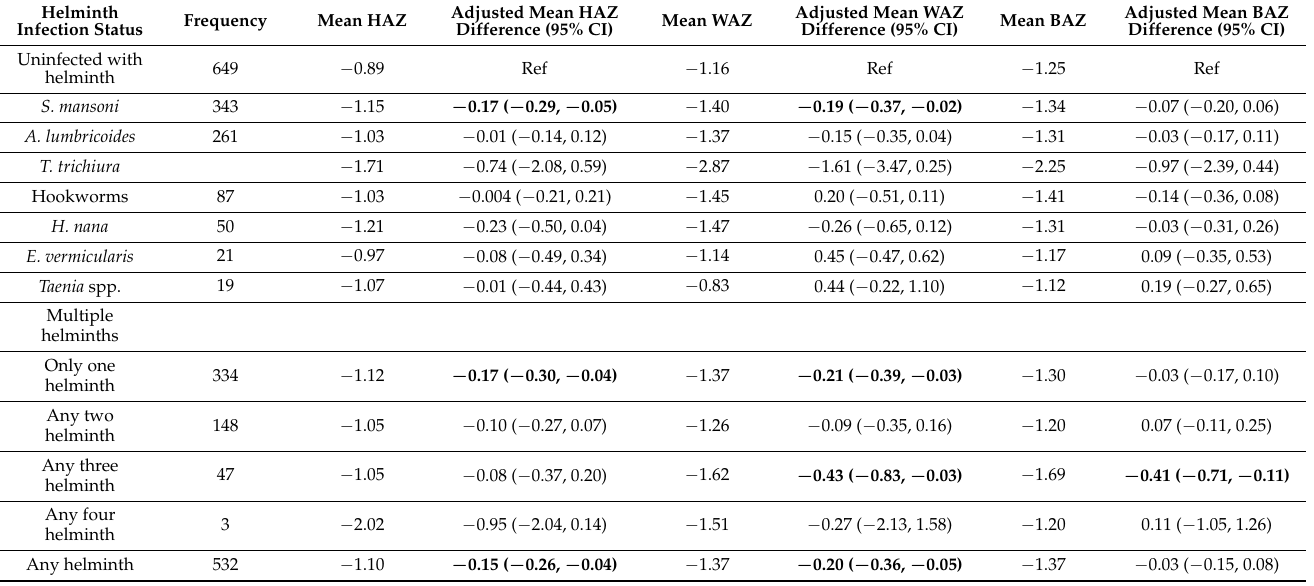
Table 5. Correlation of helminth infection status with HAZ, WAZ, and BAZ among school children in Maksegnit from May to July 2021 (N =